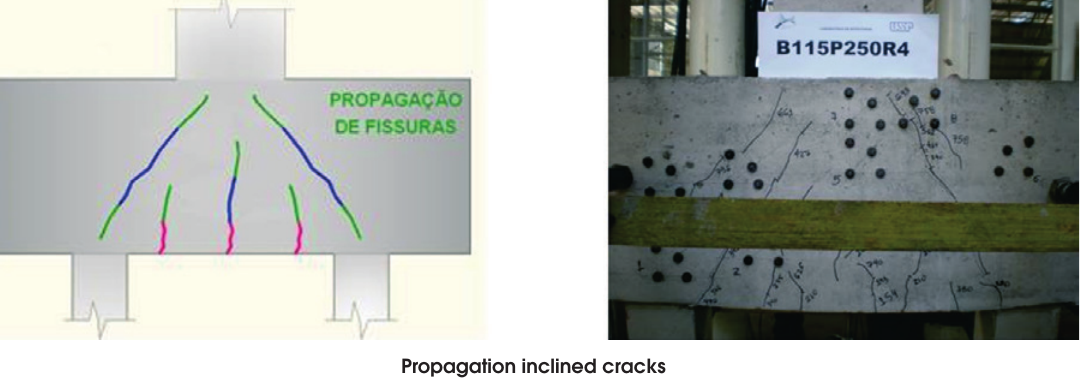
Propagation inclined cracks